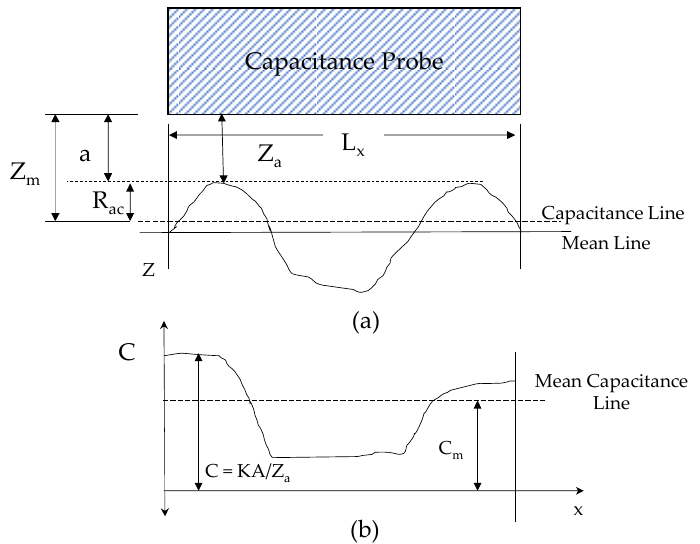
Figure 1. Capacitance sensor principle for surface roughness measurement [23] ( a ) Z-Plan of the Profile ( b ) Corresponding Capacitance Plan for the Profile.